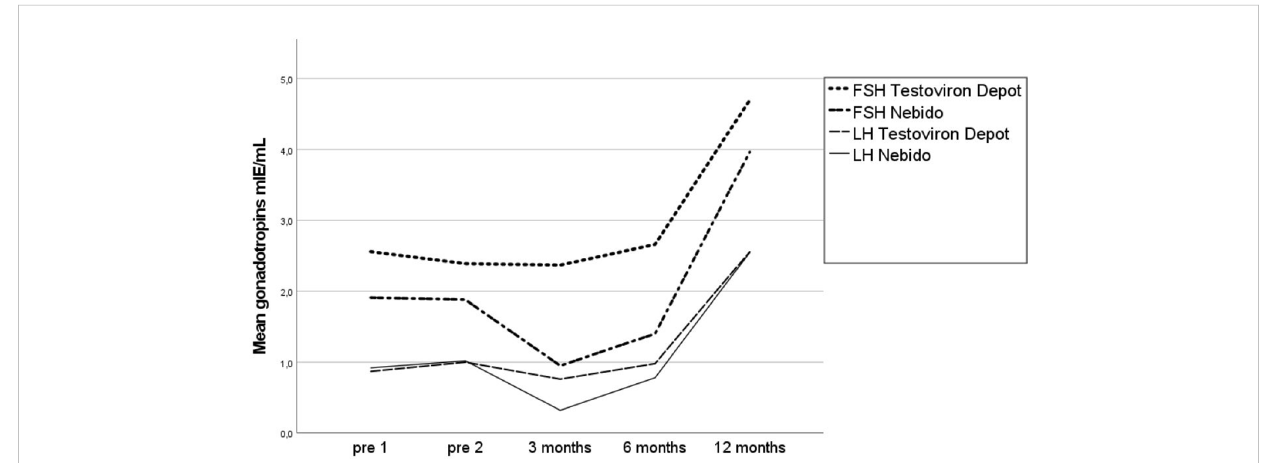
FIGURE 3 Mean gonadotropins (LH and FSH) in the Pubertal Replacement in Boys Study in the Testoviron Depot ® and Nebido ® groups measured twice before the study start and after 3, 6, and 12 months. LH, luteinizing hormone; FSH, follicle-stimulating